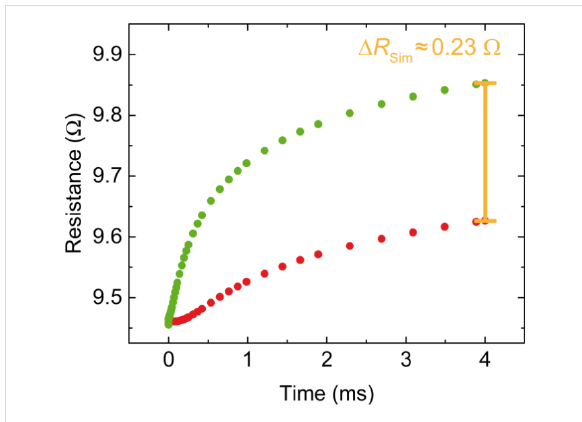
phonon scattering, we obtained an effective thickness of 63 nm.